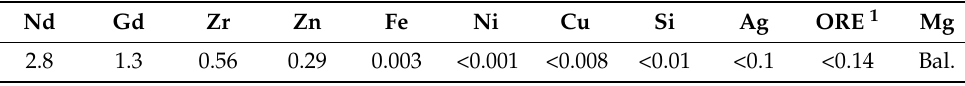
Table 1. Chemical composition (wt.%) of the EV31A Mg